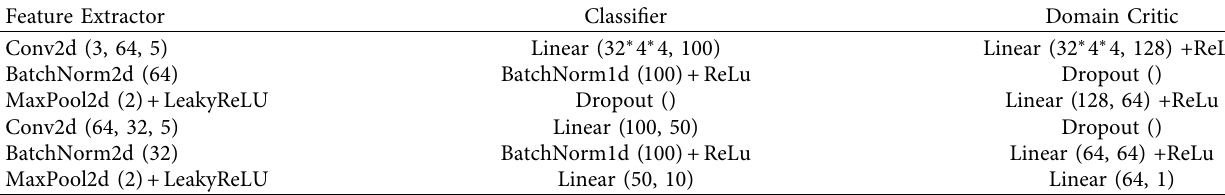
Table 2: Component architecture for MNIST.